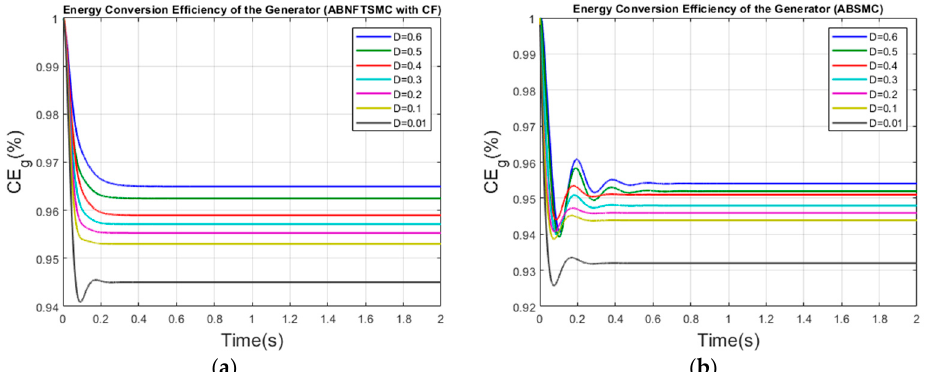
Figure 10. The comparison of energy conversion efficiency of the generator with respect to different stochastic intensity D . ( a ) ABNFTSMC with CF method; ( b ) ABSMC method [15].